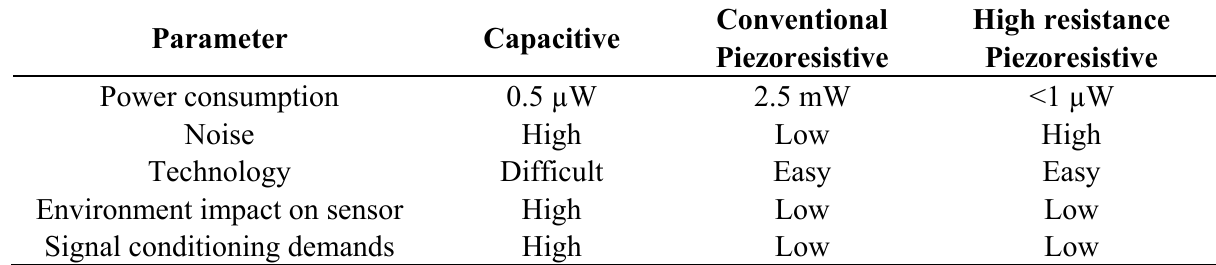
Table 1. Benchmarking of the sensing element.